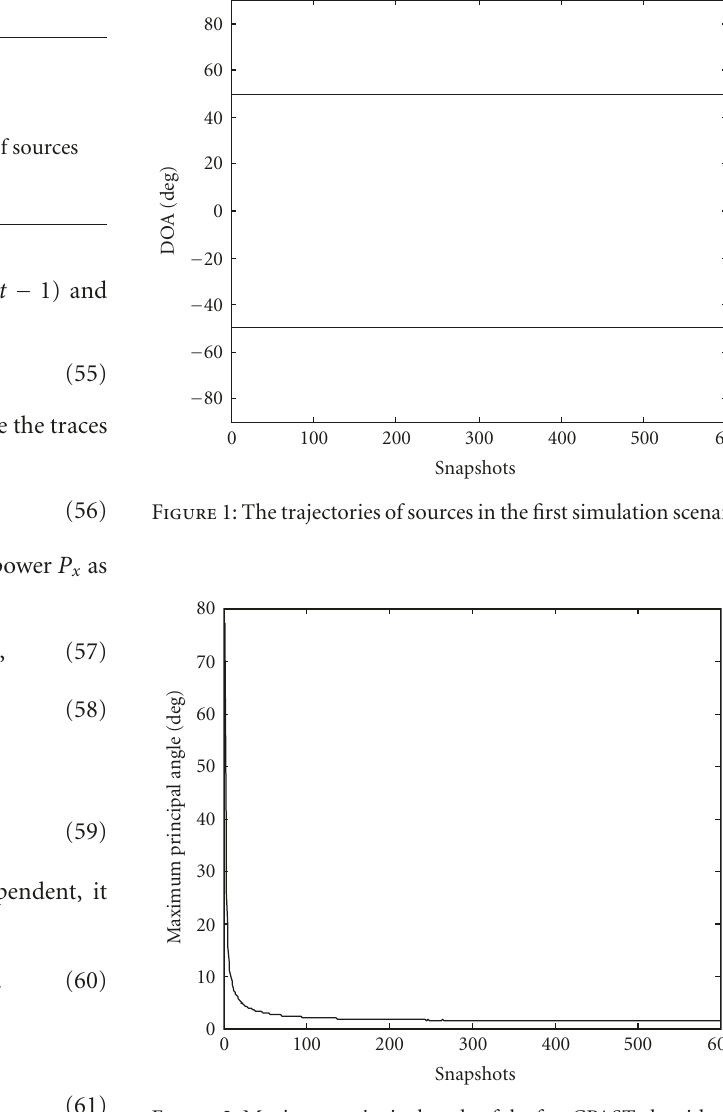
Figure 2: Maximum principal angle of the fast CPAST algorithm in the first simulation